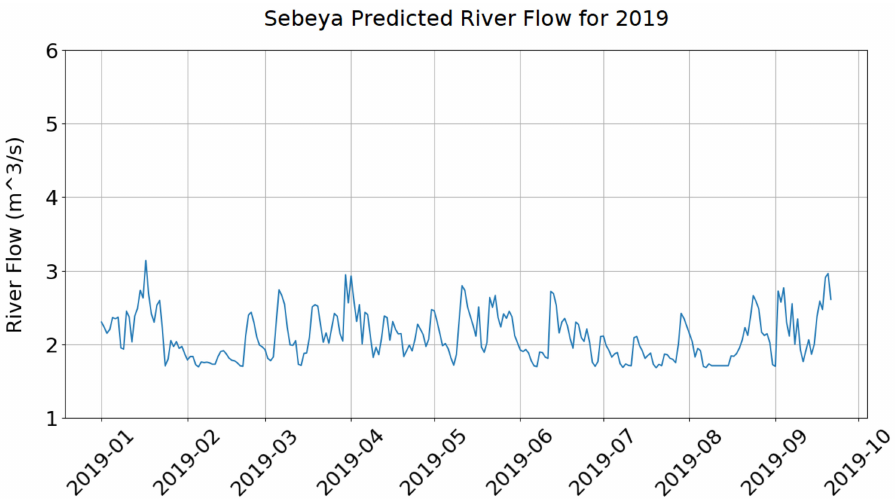
Figure 3. River flow prediction for 2019, prior to capturing high flow